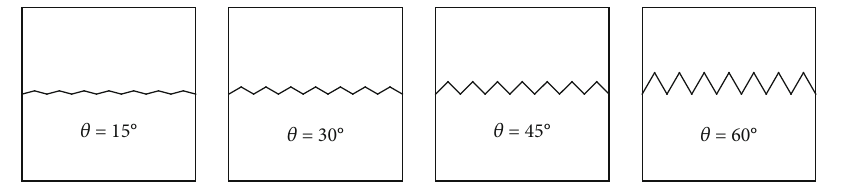
Figure 3: Samples with di ff erent undulating angles. Table 3: Groups and numbers of samples. Group Undulating angle ( ° ) No. of